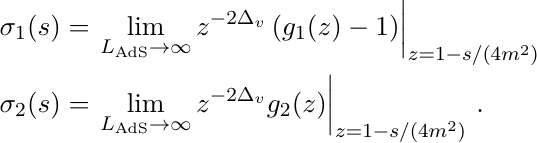
Figure 13 . Difference between the perturbative and extremal numerical value for g ∗ of g ∗ and ∆ v . The left plot corresponds to the vertex operator formulation of sine-Gordon, and 1 the right to the fermionic Thirring model description. The error is small near each description’s perturbative region. Both descriptions work well near the massless free fermion point g ∗ 1 / 2 . For reference, we also plot colored surfaces corresponding to δg ∗ corresponding to the free regimes in each